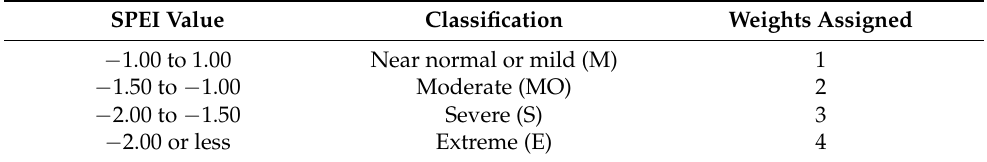
Table 1. Classification of SPEI index and weighting scheme for drought hazard assessment [28].